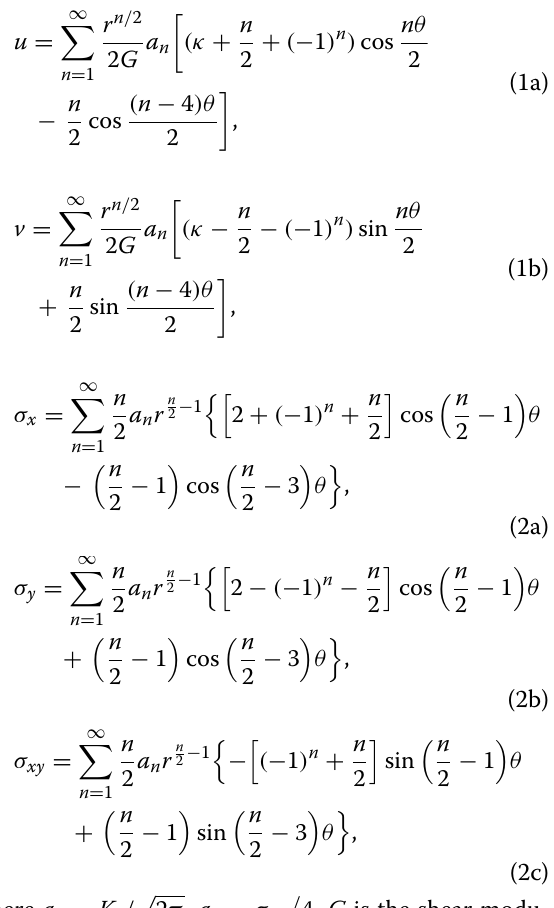
υ) for the plane stress condition, ( 1 + 3 4 υ for the plane strain condition, where υ is and κ = − Poisson’s ratio. The sample is rotated and translated dur- ing loading. The displacement field measured directly by DIC technology can be expressed as follows: